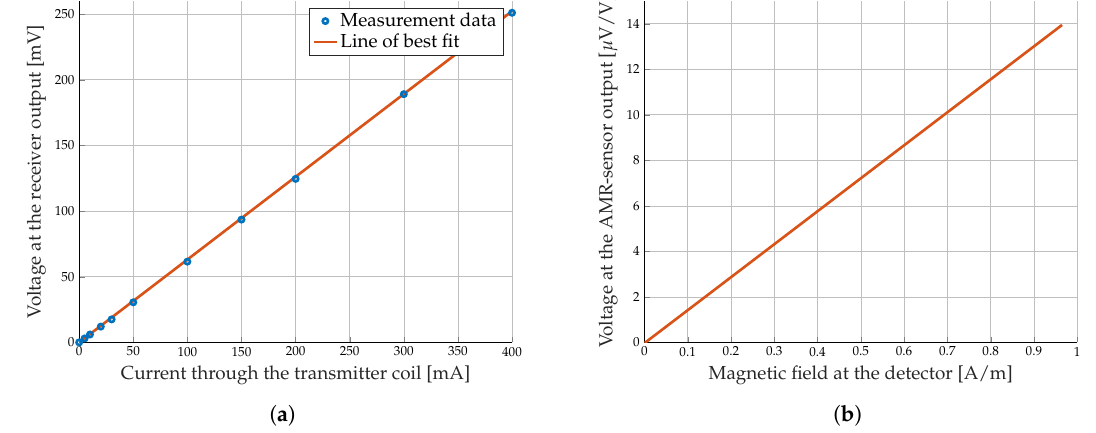
Figure 3. Measured voltage at the receiver output for different current through the transmitter coil ( a ) and the AMR sensor sensitivity curve ( b